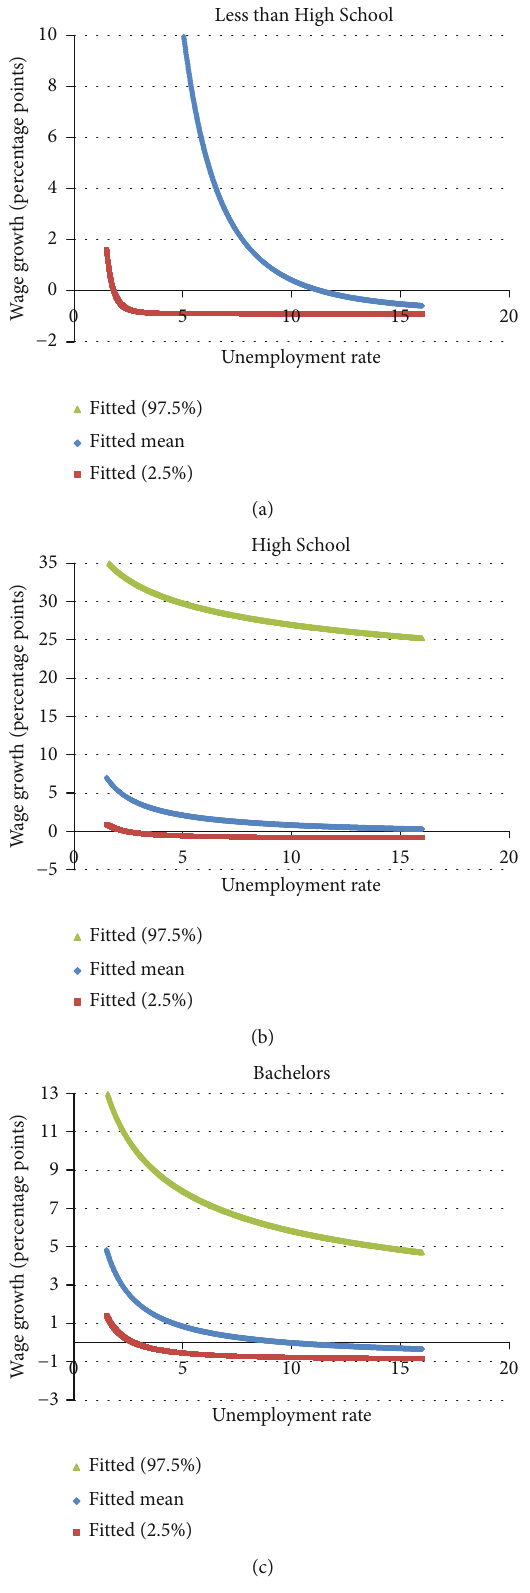
Figure 11: Relationship between wage growth and unemployment rate for Less Than High School, High School, and Bachelors group.